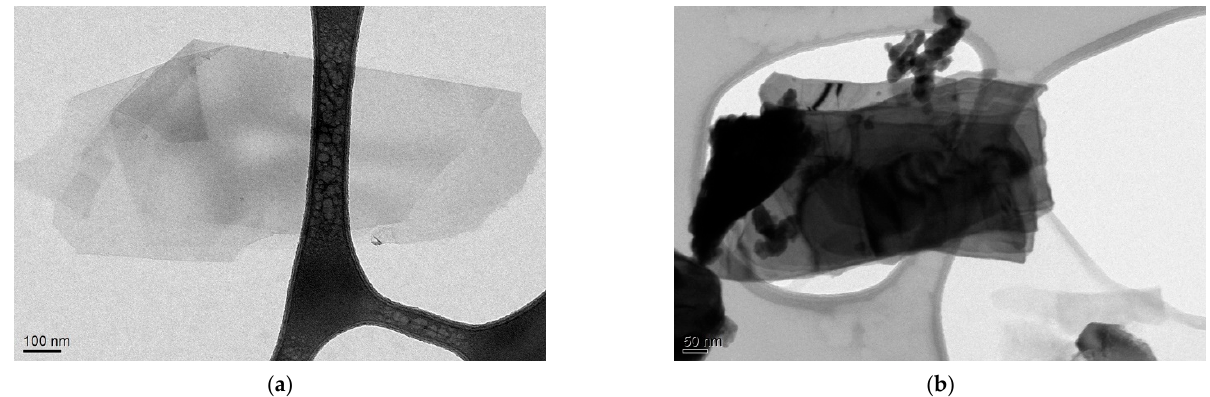
Figure 3. TEM micrographs for ( a ) graphene flakes and ( b ) bismuth telluride flakes exfoliated via WJM.